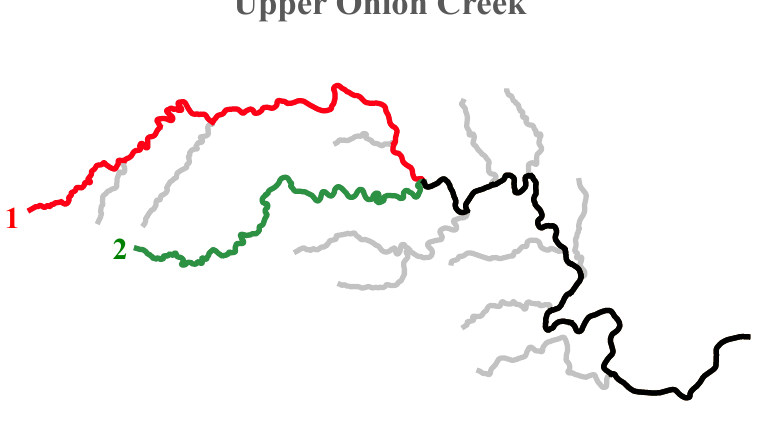
Figure 1. Flowpaths from two streamheads with unique (red and green) and overlapping (black) channels. Stream channels include the Upper Onion Creek, Texas,